Question: Condense the content of this figure into a single sentence.
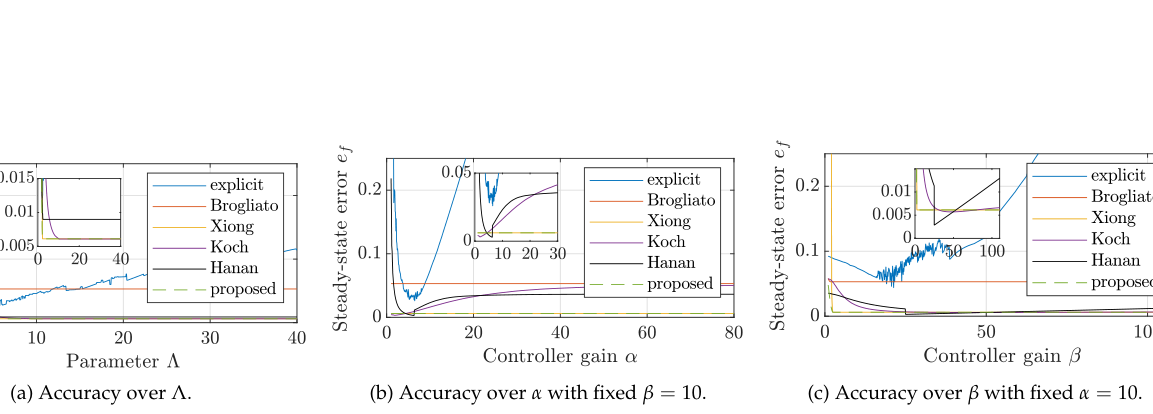
Answer: Accuracy by means of the steady-state error e f , h = 0.05 and x1(0) = 0.